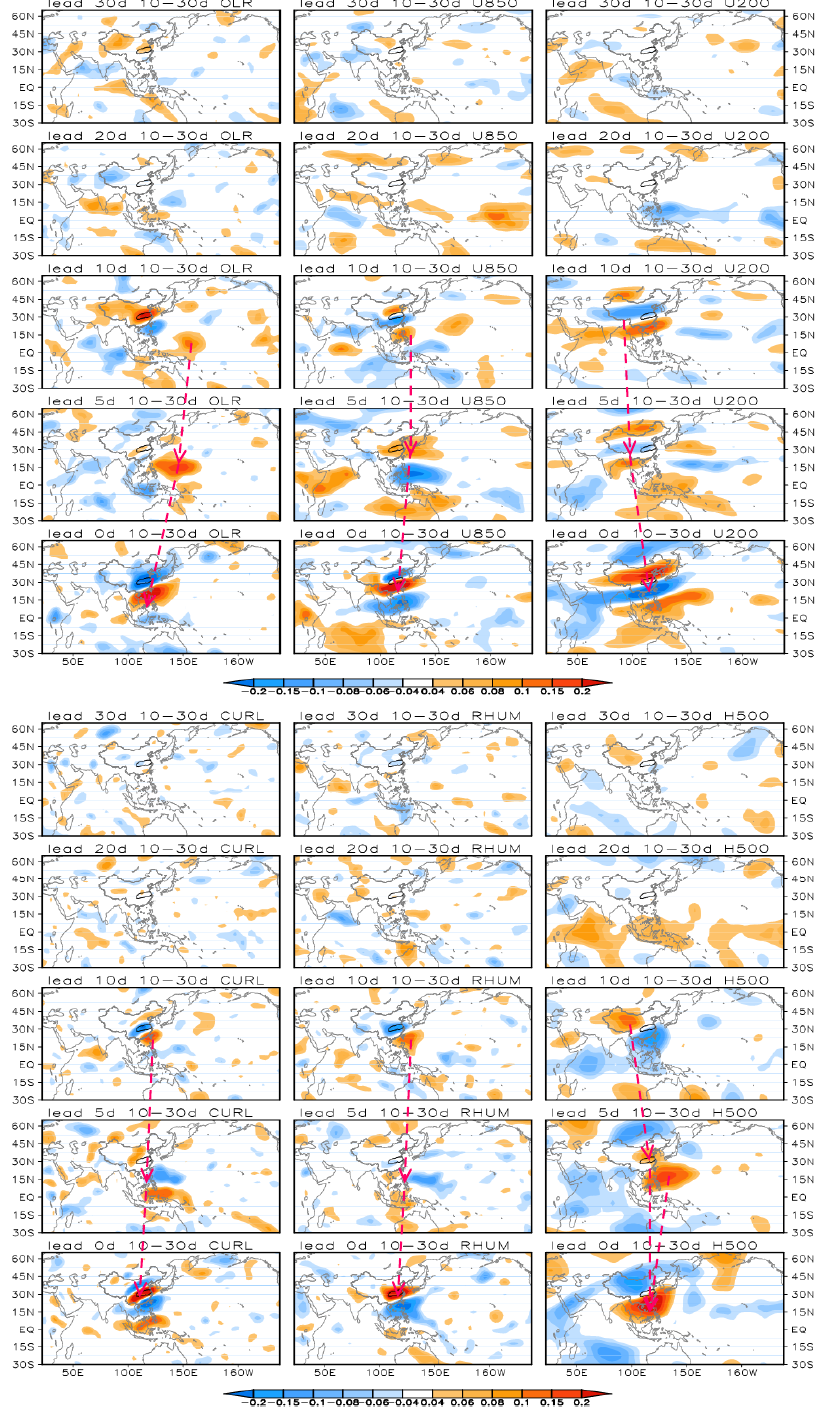
Figure 4. Same as Figure 3, but with the 10–30-day MLRYB rainfall index.